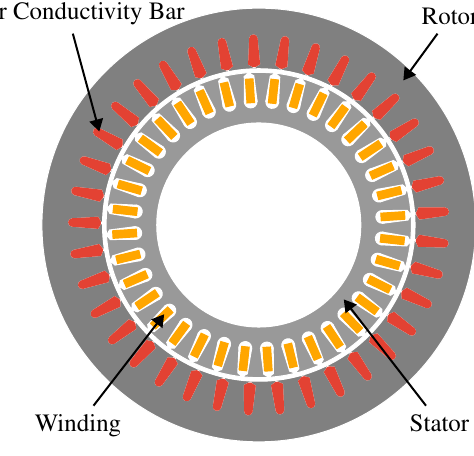
Figure 8. An outer-rotor induction motor